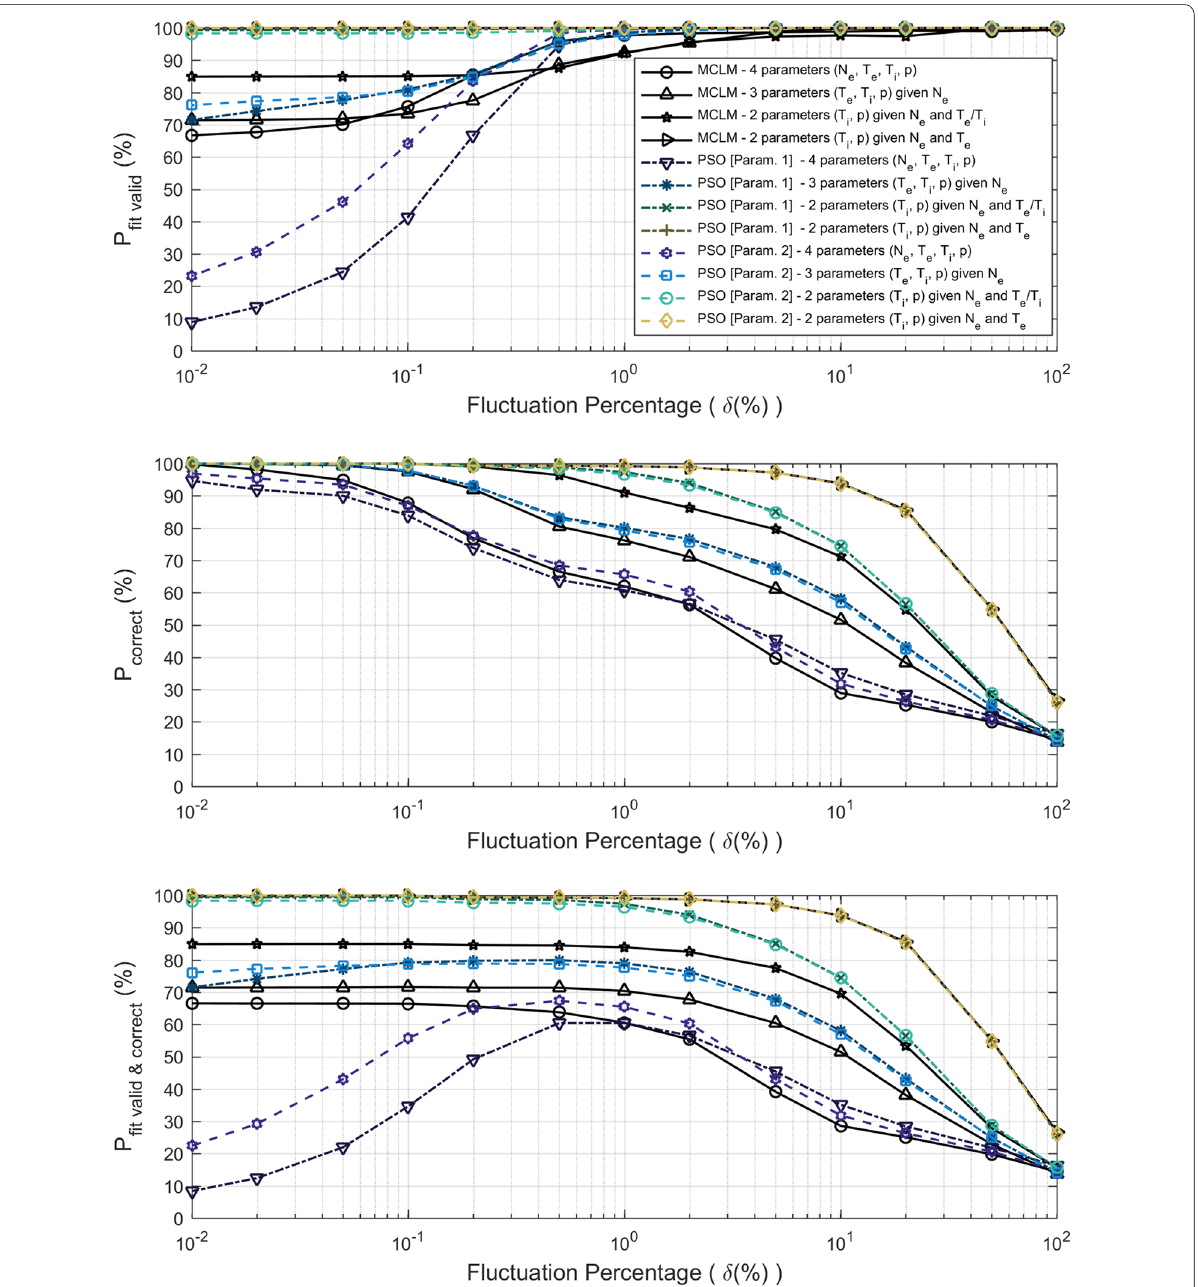
Fig. 6 Probability of convergence ( P fit valid ) and probability of ‘correct’ estimation ( P correct ) (in percentage) obtained by simulations (black continuous lines) using the MCLM method, and using the PSO algorithm with the parameter configuration (dash‑dotted lines) “Param. 1” used by Wu et al. (2015) and (dashed lines) “Param. 2”. Simulations were done at different signal fluctuation percentages ( δ( % ) ) fitting different combinations of known a priori plasma parameters from the plasma line: without a priori information, given N e , given N e and T e / T i , and given N e and T e